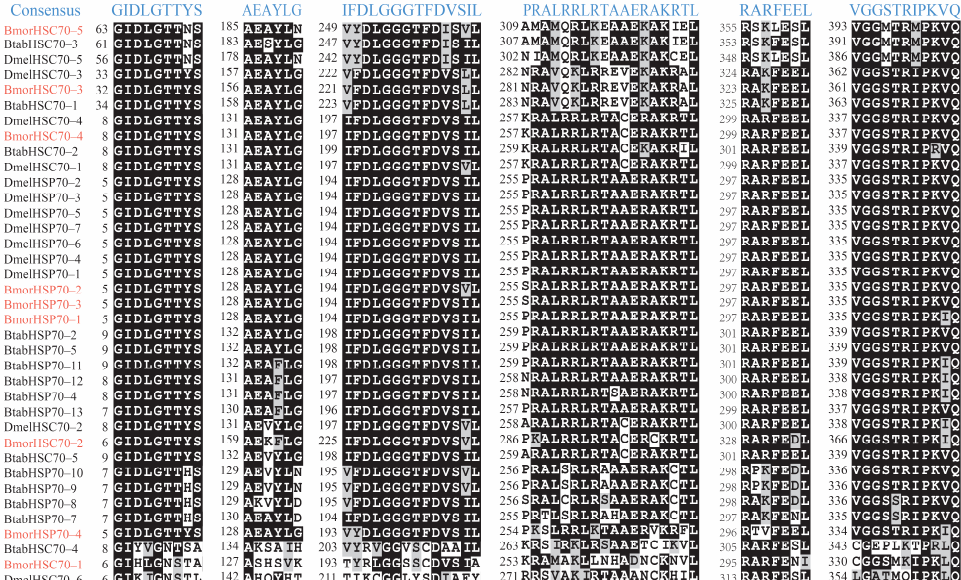
Figure 2. Signature sequences and typical regions of the heat shock proteins 70 family in B. mori , D. melanogaster , and B. tabaci . The consensus sequences were shown on the top of the alignments. The number before alignment represents the starting position in the corresponding sequence. The silkworm HSP70s/HSC70s were displayed in red. The similarity of the alignments was shaded with BOXSHADE v3.21 (https://embnet.vital-it.ch/software/BOX_form.html (accessed on 7 September 2021)).